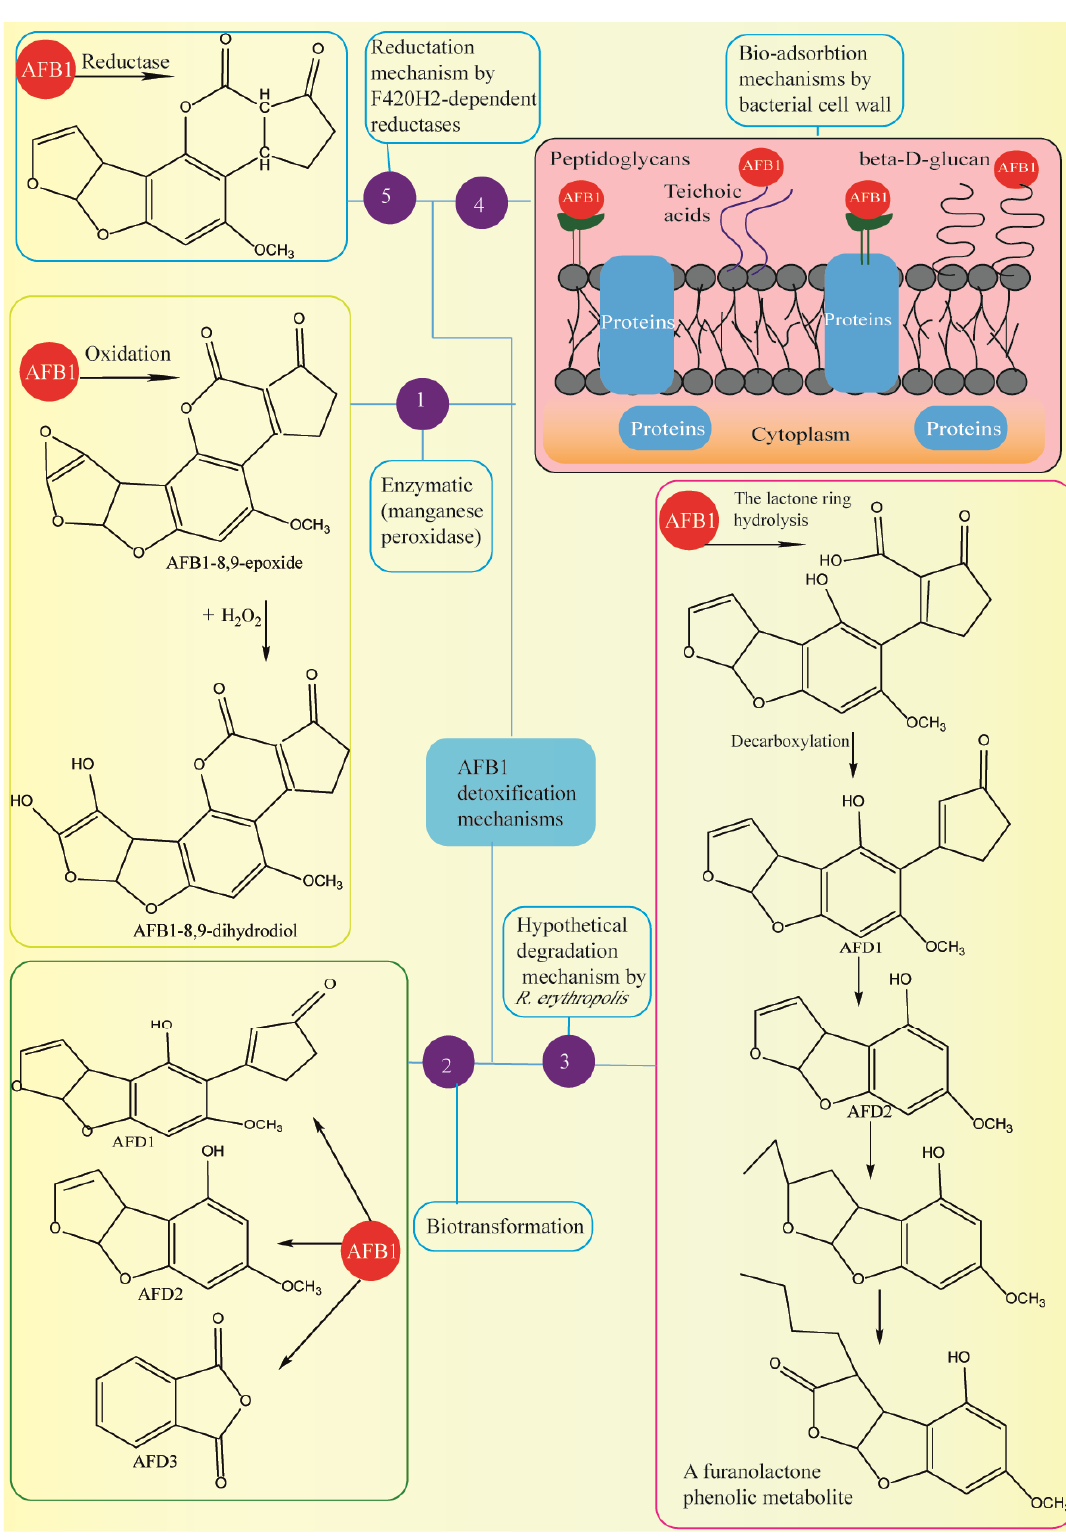
Figure 6. Overview of aflatoxins detoxification mechanisms. (1, [235]), (2, [230]), (3, [231]), (4, [224–227]), (5, [236]).